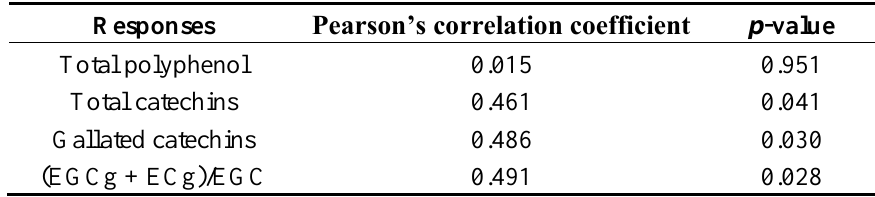
Table 6. Correlations between the antioxidant activity and response values obtained from the experimental